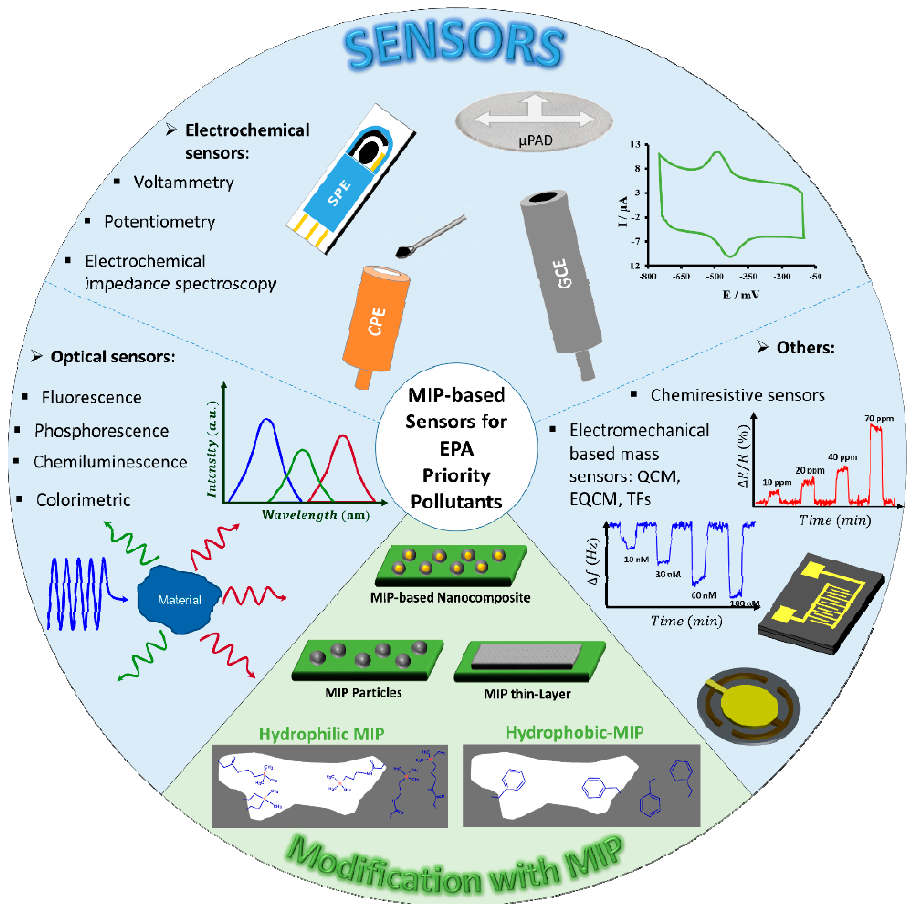
Figure 2. MIP-modified sensors for EPA Priority Pollutants.